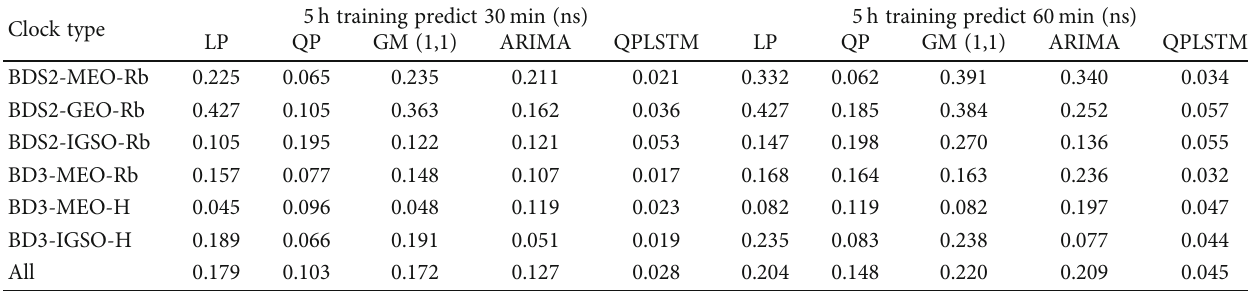
Table 4: 30min and 60 min average prediction MAE for six di ff erent clock categories based on the fi ve models for 1 h. Clock type